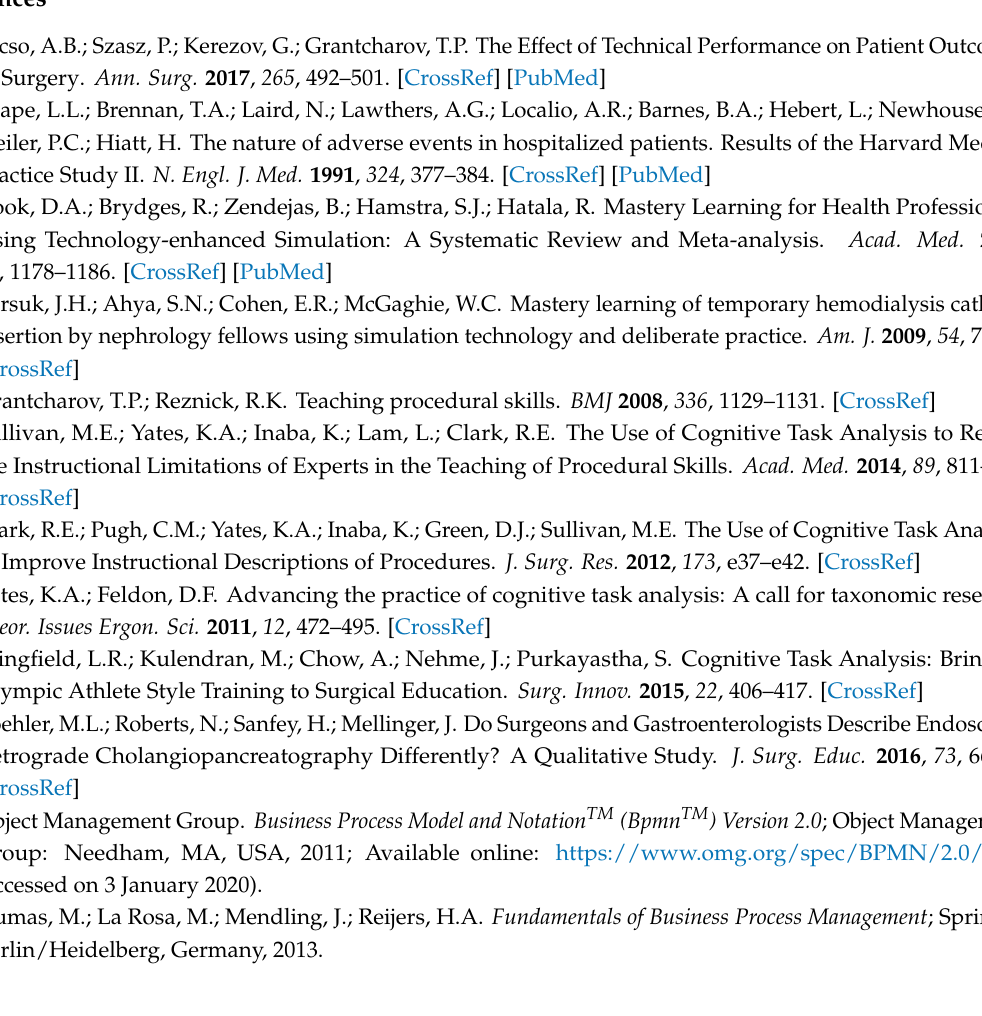
s1, Figure S1: Model of the Central Venous Access Placement with Ultrasonography used in the First Round of the Delphi Panel, represented in BPMN; Figure S2: Model of the Central Venous Access Placement with Ultrasonography used in the Second Round of the Delphi Panel, represented in BPMN; Document S3: Survey of the First Round Panel Delphi.; Document S4: Survey of the Second Round Panel